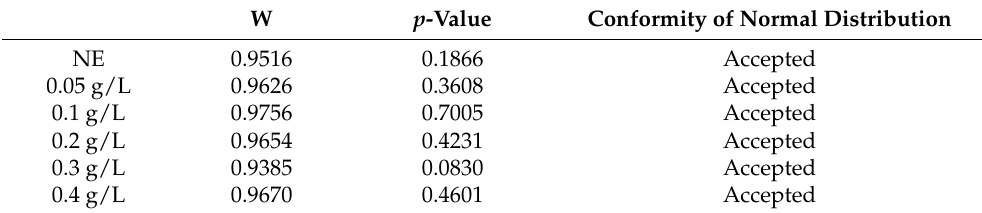
Table 3. Hypothesis test of conformity to normal distribution of NE and NFs.